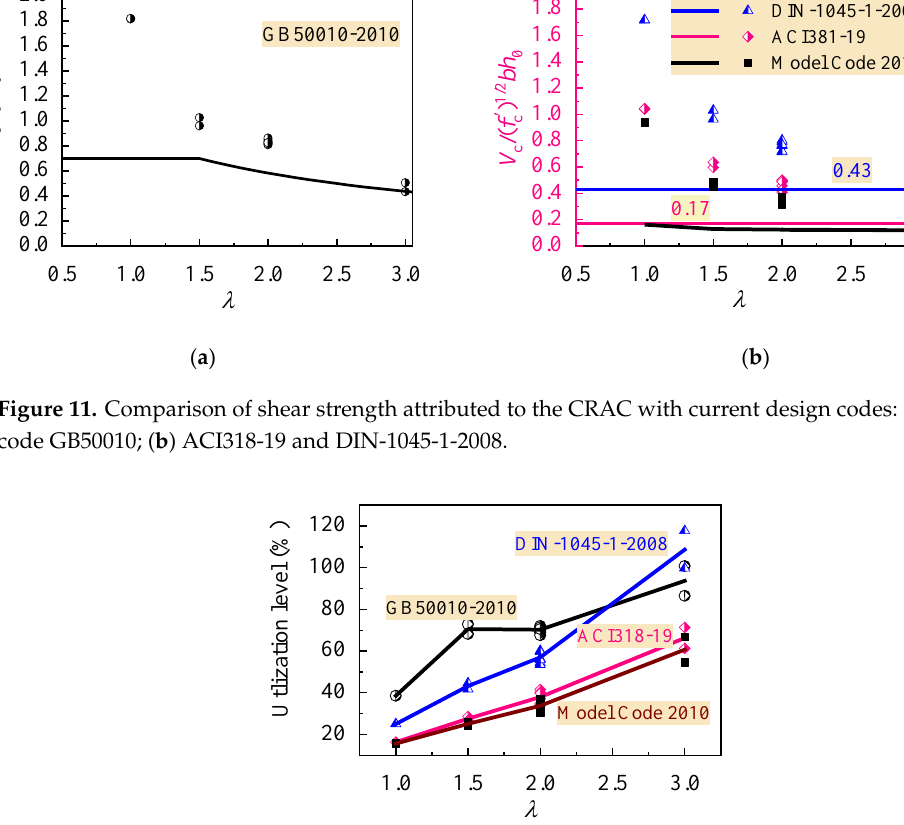
Table 5. Maximum width of diagonal cracks on test beams at normal service state. Beam ID